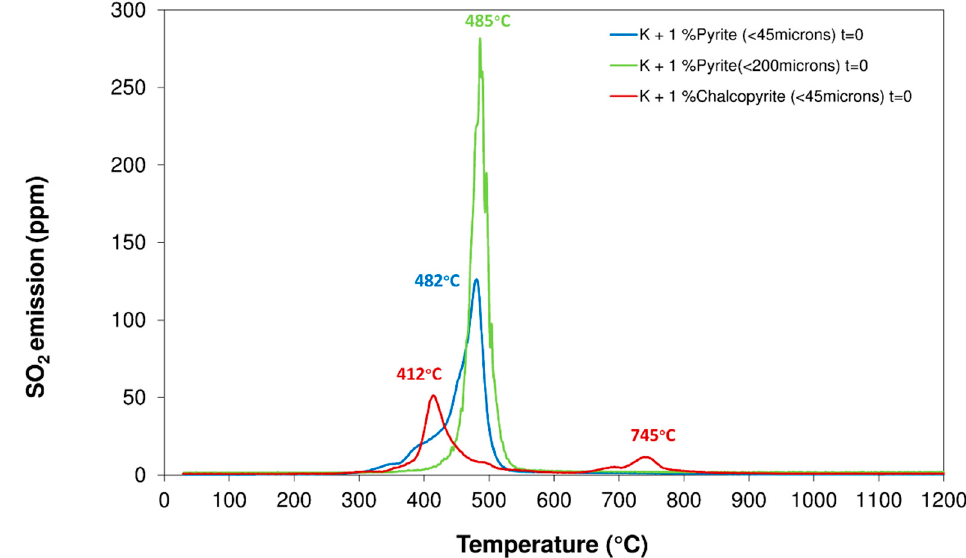
Figure 2. Evolution of the sulfur dioxide emissions of initial compositions .